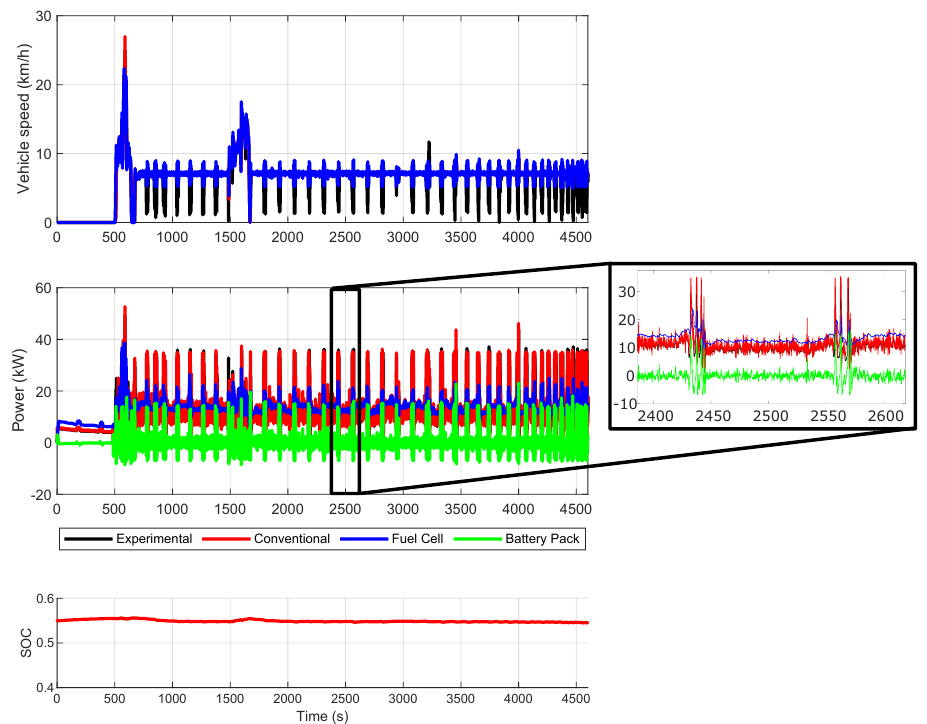
Figure 15. Simulation results for the weeding work cycle.